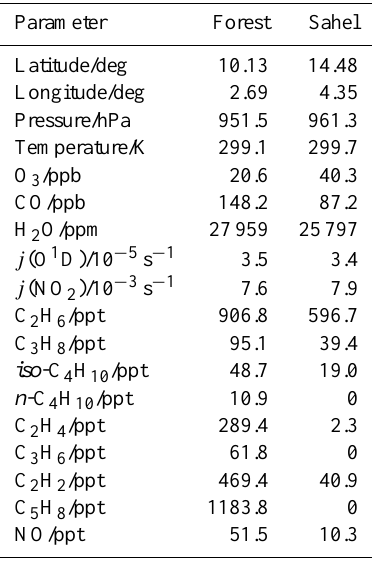
Table 3. Model inputs for the single points over the forest and Sahel used to investigate the sensitivity of the modelled HO 2 to isoprene and NO x concentrations and to investigate the processes controlling the chemistry of the forest and Sahel. For investigation of the sensi- tivity of the modelled HO 2 to isoprene and NO x concentrations the data point over the forest was used, with isoprene and NO x concen- trations as shown in Fig. 9. Chemical names are those used in the MCM.